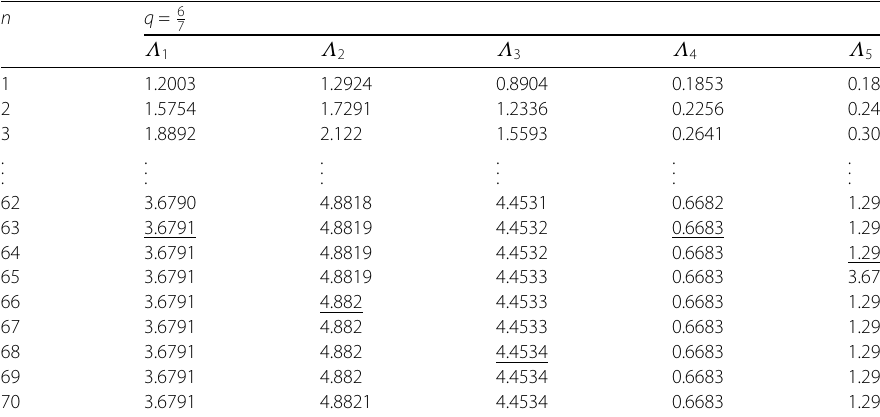
Table 9 Some numerical results of Λ i in Example 2 for q = 6